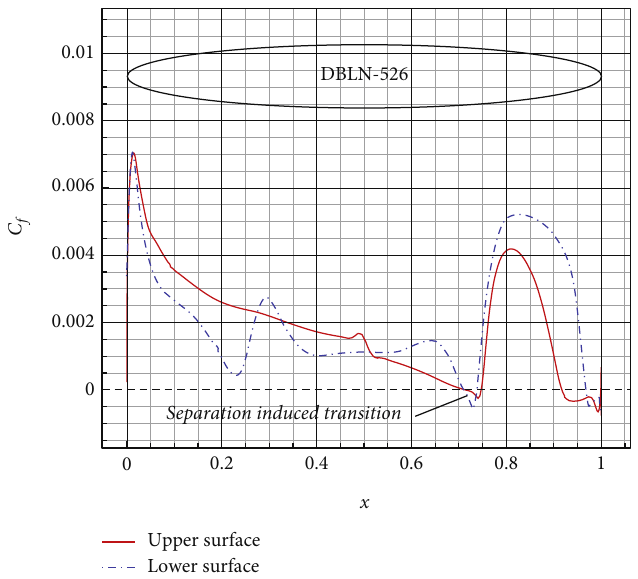
Figure 9: Skin friction distribution ( Re = 1 : 4 E 6 , α = 2 ° ).